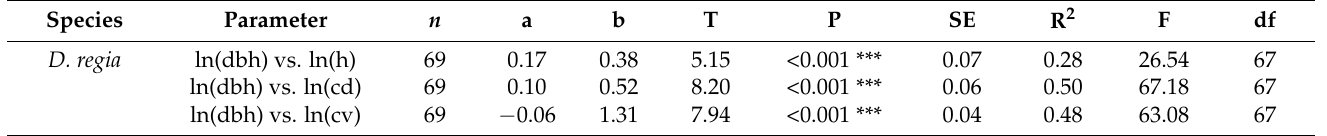
Table 2. Results of linear regression analyses using dbh as a predictor variable and h, cd, and cv as response variables. The equation used was ln(y) = a + b ln(x). The abbreviations used were (dbh) diameter at breast height; (h) tree height; (cd) crown diameter; (cv) crown volume; a and b for regression coefficients; T for T -test value; P for p -value (with levels of significance indicated by symbols such as *** and *); R 2 for coefficient of determination; F for F-test value; and df for degree of freedom and standard error (SE).